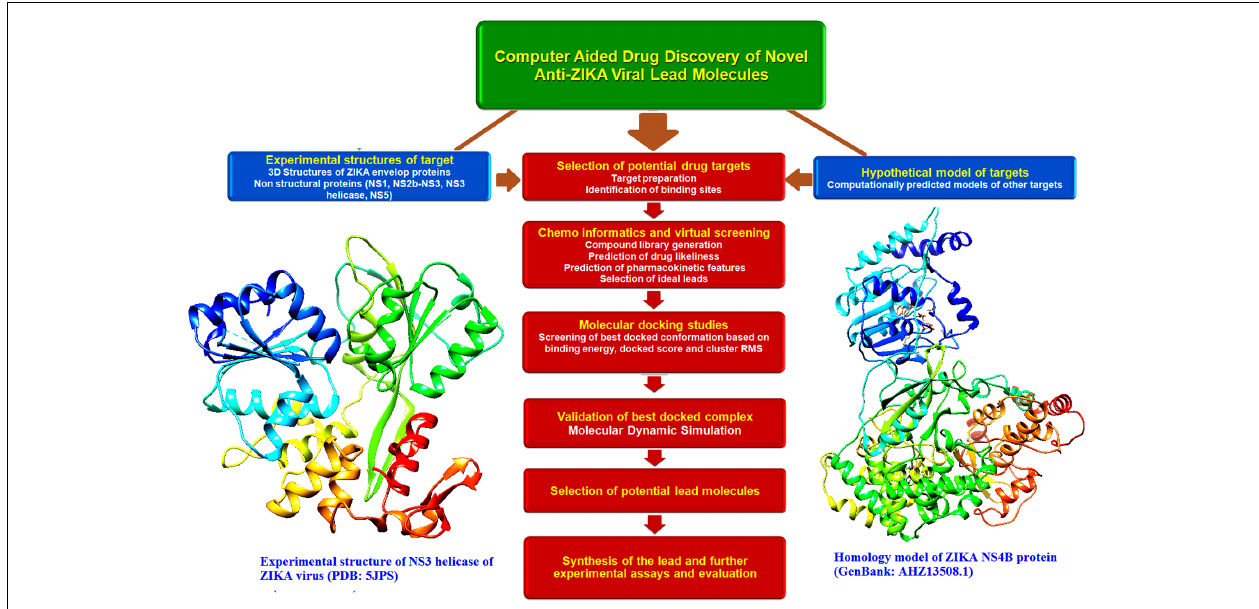
FIGURE 5 | Schematic representation of the major concepts involved in the computational drug discovery of novel anti-Zika viral lead molecules. Drug discovery processes involved in the selection of novel and probable drug targets (both experimental structures and hypothetical models), selection of novel leads with ideal drug likeliness and pharmacokinetic properties, study of target-lead interaction by molecular docking, validation of the best docked poses by molecular dynamic simulation, selection of the best lead molecules, synthesis and large scale screening of the best leads and further experimental